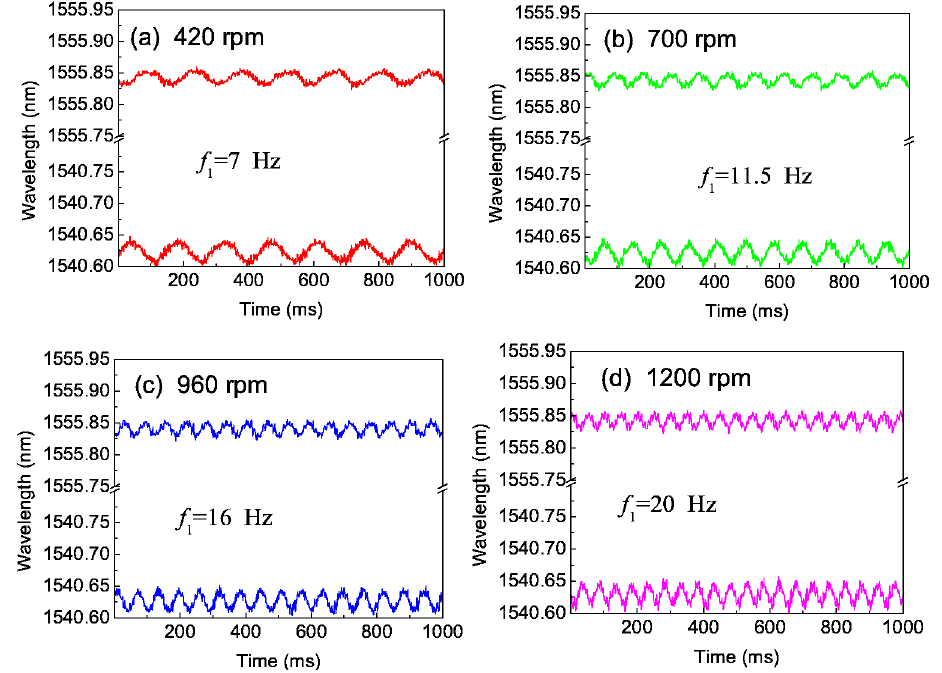
Figure 7. Central wavelengths of two FBGs with the time for four rotation speeds: ( a ) 420, ( b ) 700, ( c ) 960 and ( d ) 1200 rpm.